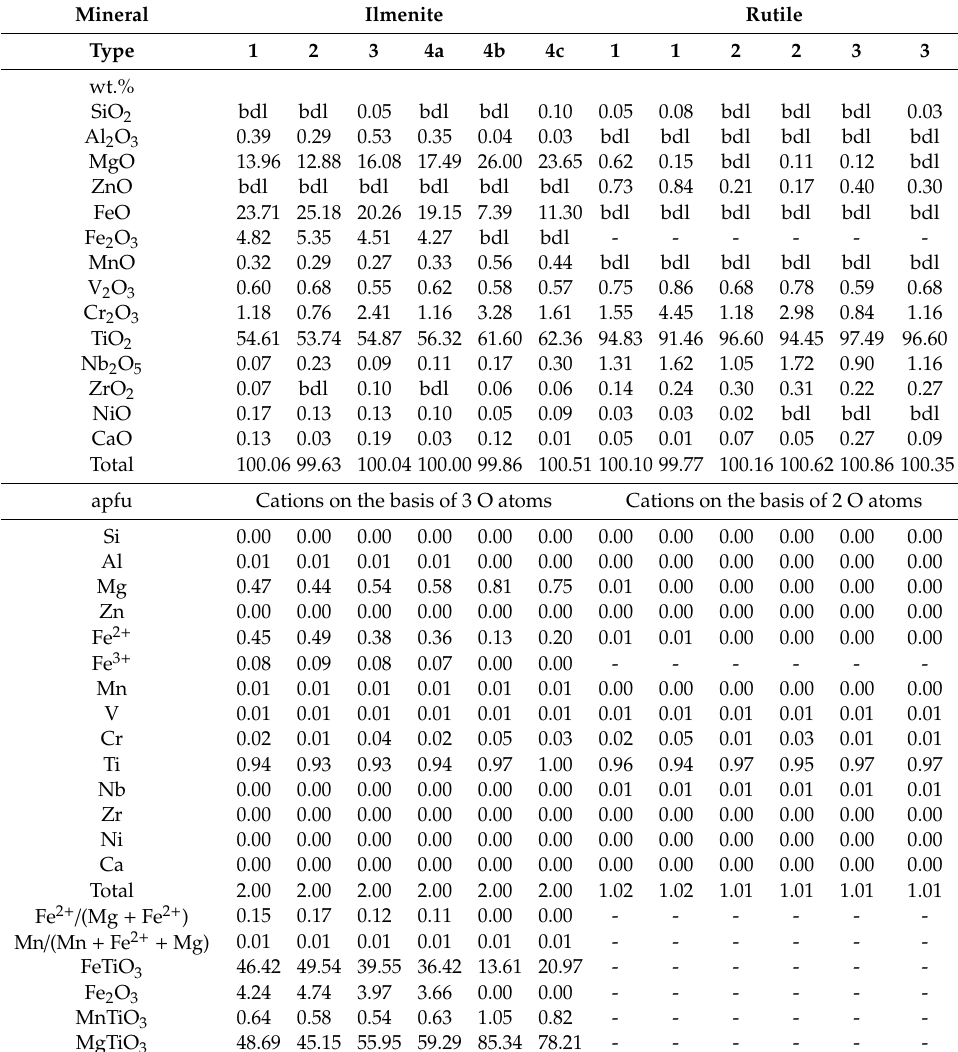
Table 2. Representative analyses of di ff erent types and subtypes of ilmenite and rutile. Mineral Ilmenite Rutile Type